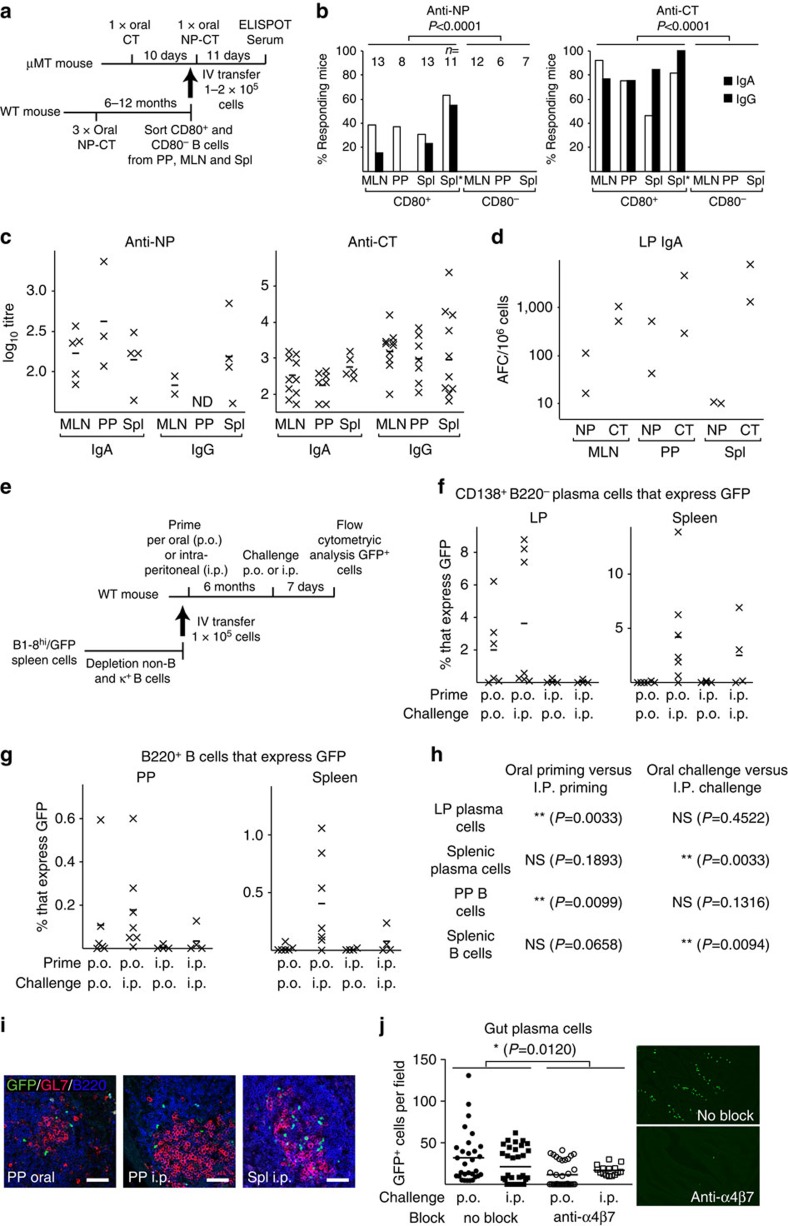
Re-circulating CD80+ memory B cells formed after oral immunization generate α4b7-dependent gut IgA responses.(a) Wild-type C57BL/6 mice were orally primed with three doses of 20 μg NP-CT at 10 days apart and 6–12 months later CD80+ and CD80− B cells from the Spl, MLN or PP were sorted using a FACSAria and injected intravenously into μMT recipient mice that had been orally immunized once with 10 μg of CT 10 days earlier. One day after cell transfer μMT mice were orally immunized with 20 μg NP-CT and the anti-NP and anti-CT responses in serum or SI LP (AFC) were monitored. (b) Depicts the frequency of responding mice based on detection of anti-NP (left) or anti-CT (right) IgA or IgG serum antibody responses (as depicted in c) after transfer of CD80+ or CD80− B cells using 1 × 105 cells from MLN and PP and 2–10 × 105 from the spleen (Spl). The number of recipient mice in each group (n=) is given in the left panel for NP responses. (c) Specific log10 antibody titres in individual mice that responded to an oral challenge immunization (ND, not detectable). (d) Small intestinal LP anti-NP or anti-CT IgA responses given as AFCs/106 cells in μMT mice injected with CD80+ memory B cells from indicated tissues. The data presented in a–d are based on the data pooled from four independent experiments giving similar results. (e) Mice adoptively transferred with NP-specific GFP-expressing B cells were orally or i.p. primed with NP-CT and 6 months later a challenge dose with NP-CT was given orally or i.p. (f–i) The percentage of GFP+ CD138+/all plasma cells in the SI LP and spleen of responding mice (f) and GFP+ B220+/all B cells in the PP and spleen in these mice (g). (h) A statistical analysis of the impact of p.o. versus i.p. priming or p.o. versus i.p. challenge immunizations for strong IgA responses (explained in Supplementary Fig. 6b,c). (i) Tissue sections of the PP and spleen showing GC location of responding of GFP+ memory B cells after challenge. (j) Orally primed mice were treated with α4β7-blocking DATK32 Mab before and during p.o. or i.p. challenge immunizations with NP-CT and the number of GFP+ plasma cells in SI LP sections were determined (explained in Supplementary Fig. 6a). The Mann–Whitney nonparametric test was used for statistical analysis of GFP+ gut homing plasma cells in the presence or absence of α4β7 Mab blockade (P=0.0120). Results in e–j are based on the pooled data from three independent experiments.